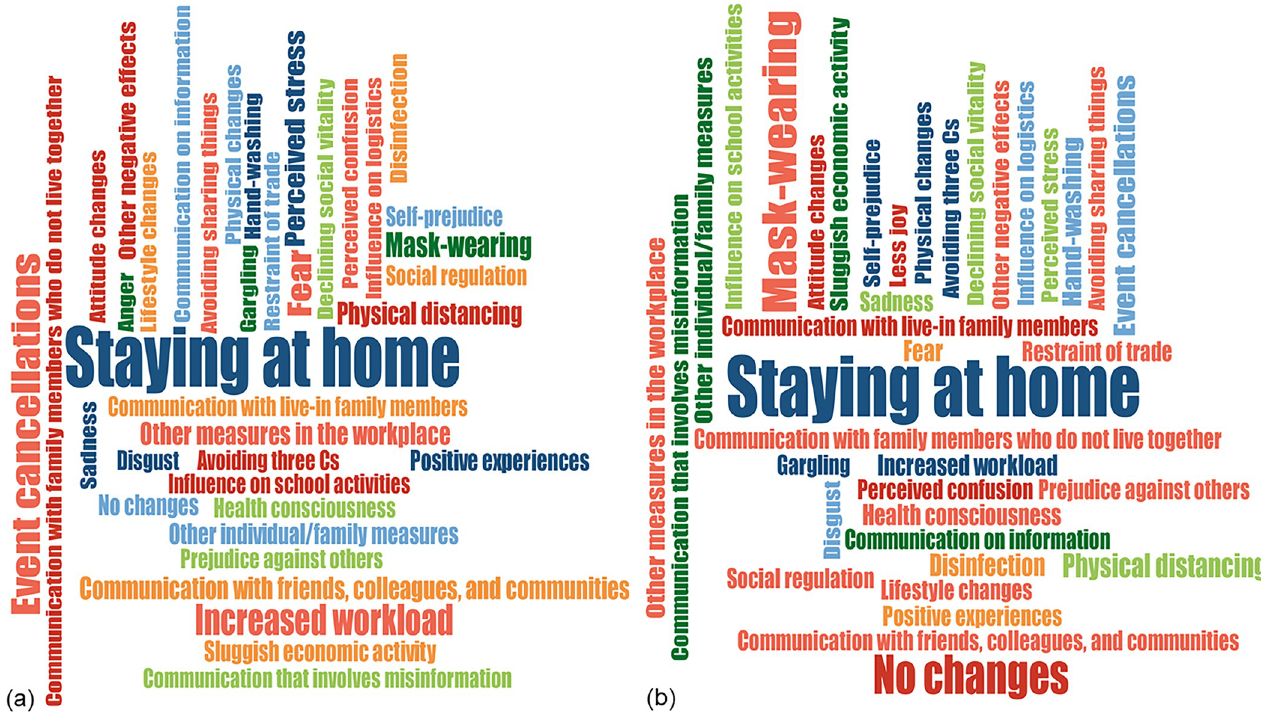
Fig 1. Flowchart of participant enrollment in the